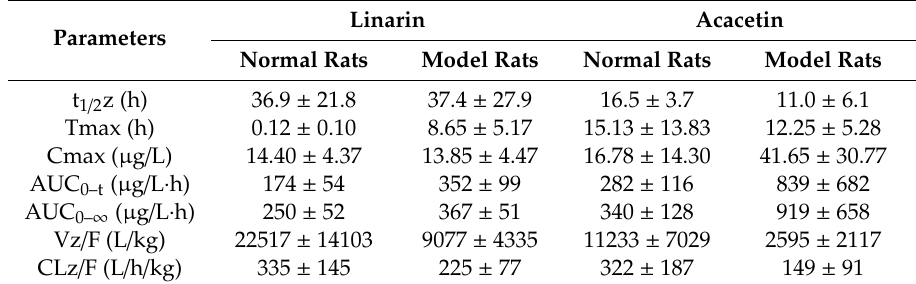
Table 5. Pharmacokinetic parameters of linarin and acacetin after a single oral administration of linarin in normal rats and model rats.